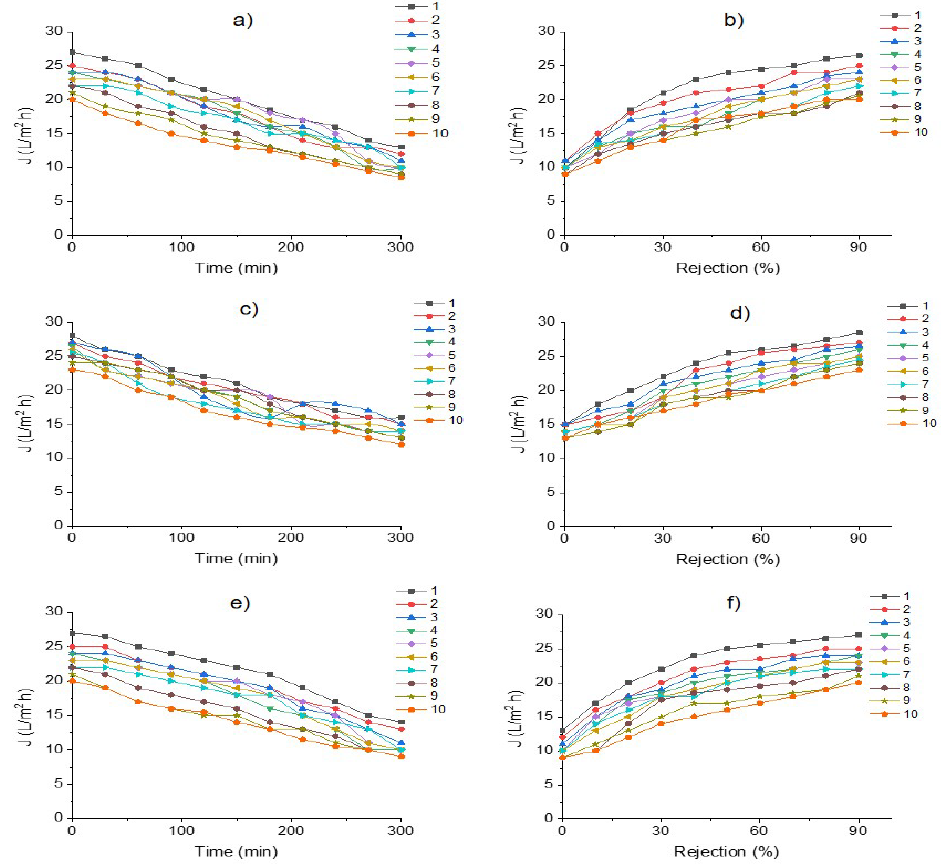
Figure 6. Figure 6 shows RO membrane behavior during the desalination process of industrial effluent treatment, exhibiting declines in water fluxes (permeation curves J, L/m 2 h). Membrane and salts removal efficiency by TDS removal (Rejection%) after 10 runs of the stability period of permeation during effluent treatment is also included; feed flow to RO: ( a , b ) 0.5 L/h; ( c , d ) 0.7 L/h; ( e , f ) 1 L/h.